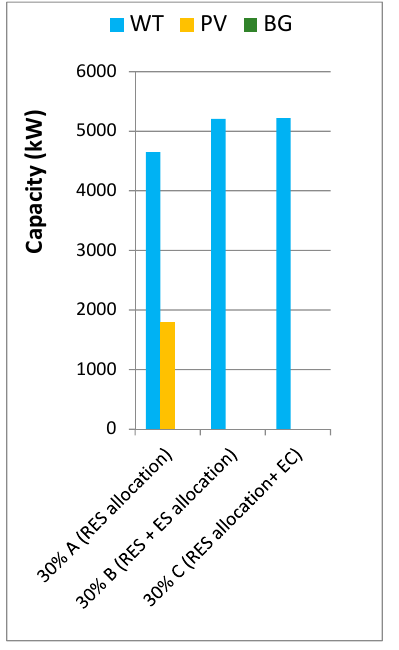
Figure 4. Structure of capacity for main scenarios—1 .